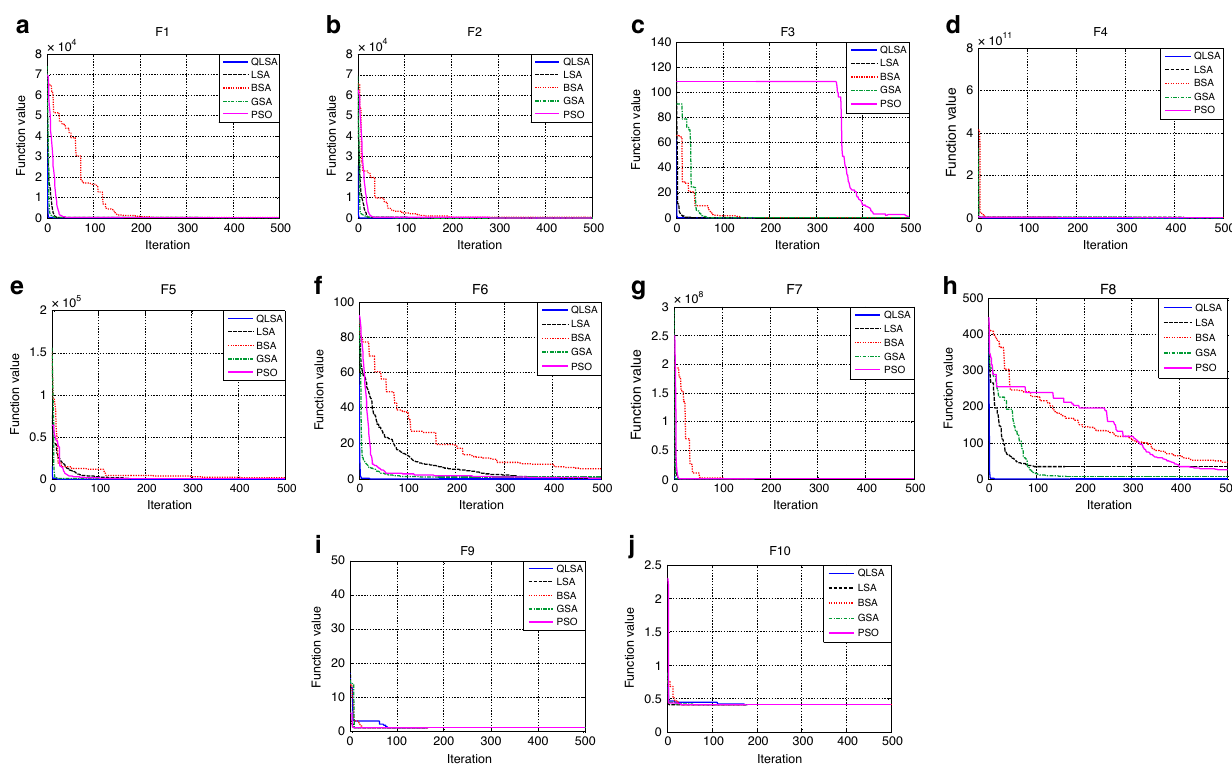
Fig. 2 The convergence characteristics performance evaluation of QLSA, LSA, BSA, GSA and PSO under different benchmark functions. a Convergence characteristic curves for QLSA, LSA, BSA, GSA and PSO in benchmark function F1 (Sphere). b Convergence characteristic curves for QLSA, LSA, BSA, GSA and PSO in benchmark function F2 (Step). c Convergence characteristic curves for QLSA, LSA, BSA, GSA and PSO in benchmark function F3 (Quartic). d Convergence characteristic curves for QLSA, LSA, BSA, GSA and PSO in benchmark function F4 (Schwefel 2.22). e Convergence characteristic curves for QLSA, LSA, BSA, GSA and PSO in benchmark function F5 (Schwefel 1.2). f Convergence characteristic curves for QLSA, LSA, BSA, GSA and PSO in benchmark function F6 (Schwefel 2.21). g Convergence characteristic curves for QLSA, LSA, BSA, GSA and PSO in benchmark function F7 (Rosenbrock). h Convergence characteristic curves for QLSA, LSA, BSA, GSA and PSO in benchmark function F8 (Rastrigin). i Convergence characteristic curves for QLSA, LSA, BSA, GSA and PSO in benchmark function F9 (Foxholes). j Convergence characteristic curves for QLSA, LSA, BSA, GSA and PSO in benchmark function F10 under the identical SR. The proposed QLSAF controller is also observed to be superior to other controllers in terms of achieving low MAE, RMSE and SD under each step change in speed or load.